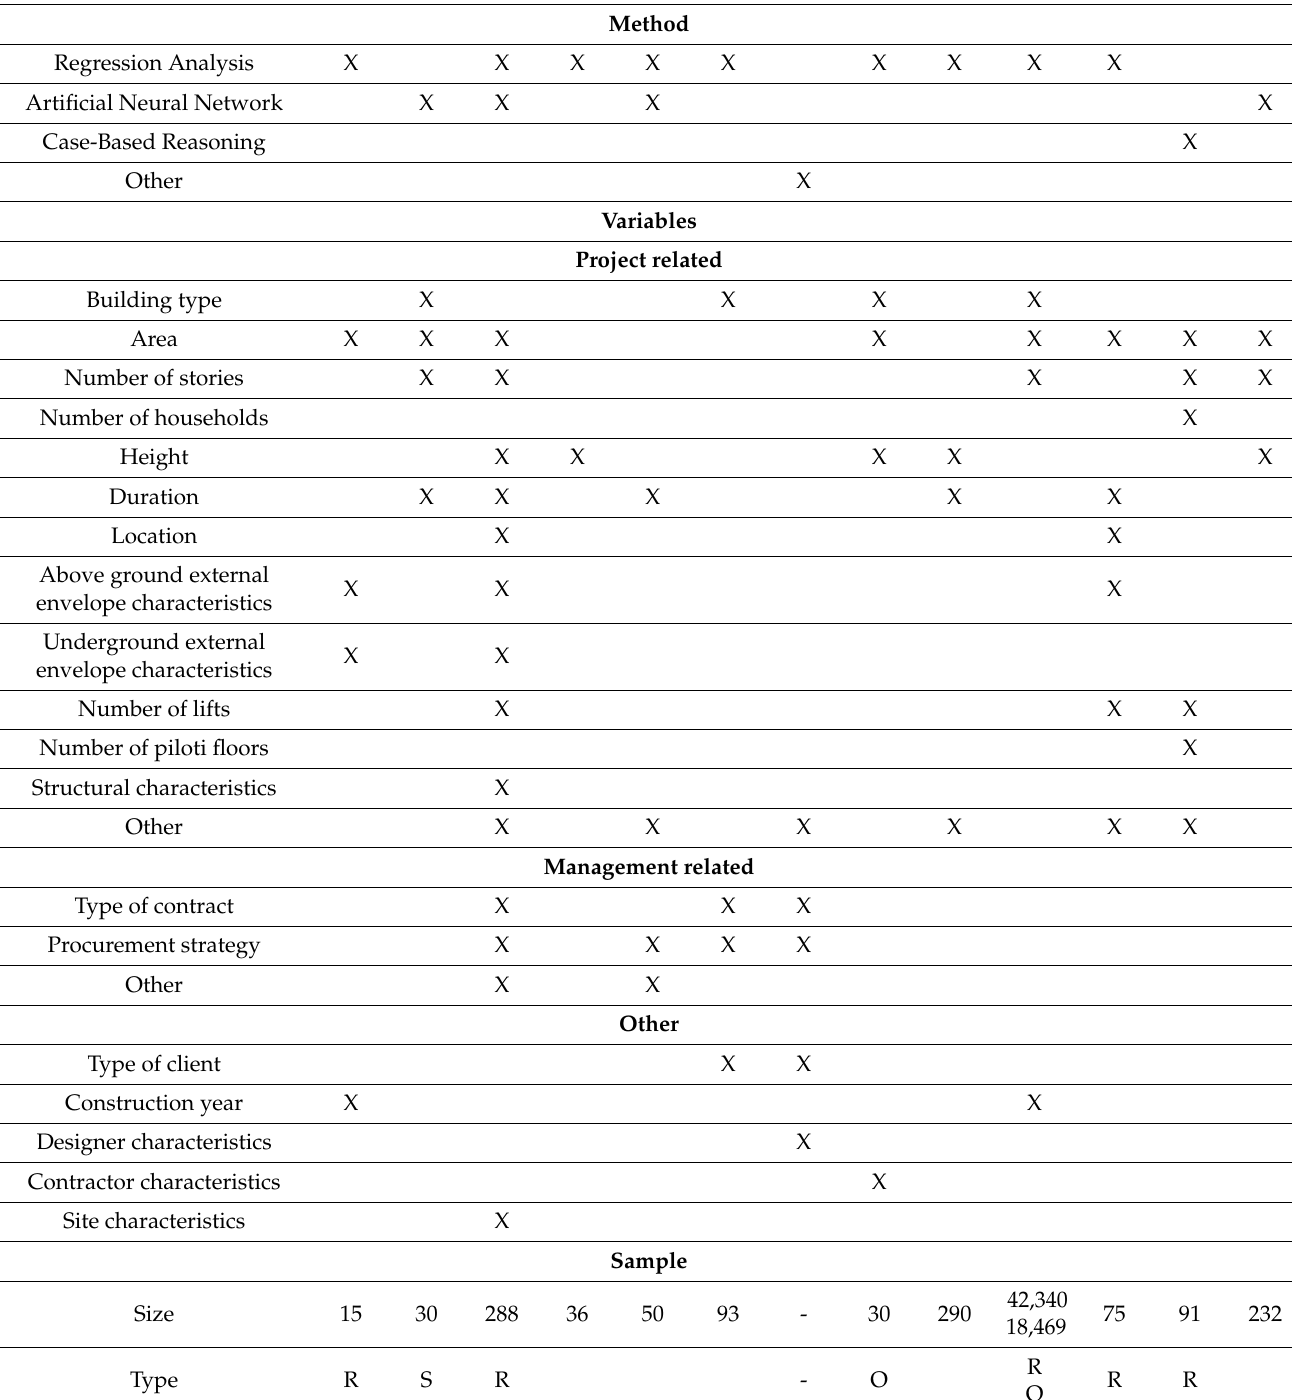
Table 1. Early-stage cost estimation models for